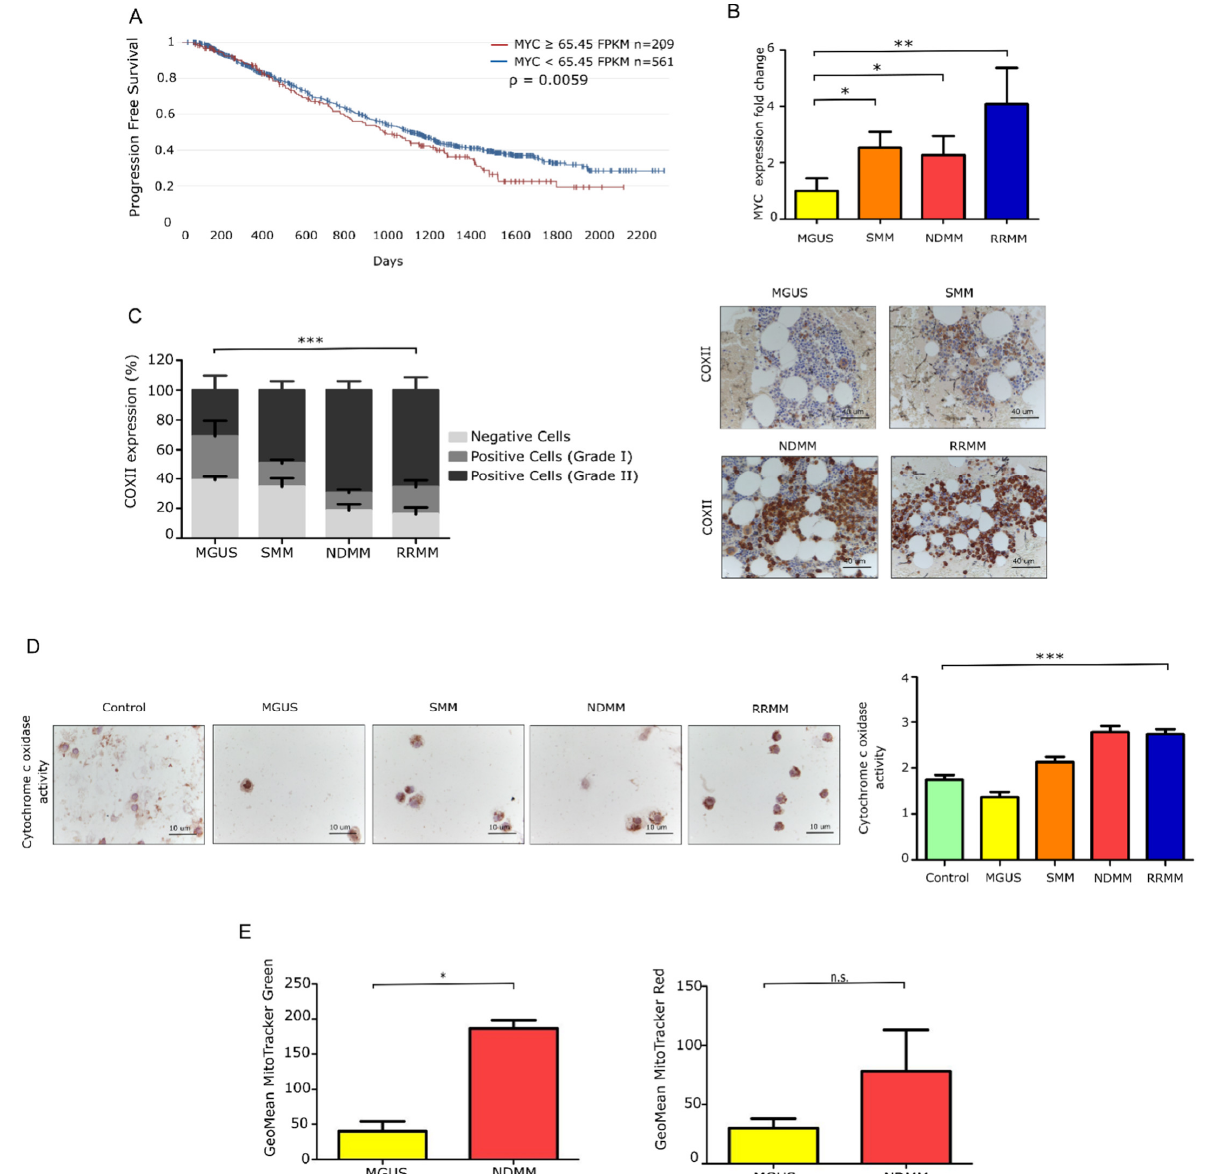
Figure 1. Mitochondrial features in primary MM cells from distinct myeloma entities. ( A ) Progression-free survival (PFS) of MM patients from the CoMMpass study (IA14) stratified according to MYC gene expression. ( B ) Fold-change in gene expression of MYC relative to GUS B expression (MGUS N = 9; SMM N = 9; NDMM N = 18; RRMM N = 11). Data are presented as mean values ± SEM of technical triplicates. ( C ) Intracellular expression of COXII in samples from MM patients ( N = 4 MGUS, N = 7 SMM, N = 13 NDMM, and N = 11 RRMM). Microscopy analysis of the immunohistochemistry (IHC) slides from bone marrow samples ( p value = 0.0001). Representative images addressing differences in COXII expression between patients at different stages of the disease. Scale bar, 40 µm. Data are presented as mean values ± SEM. Statistical significance was assessed using two-way ANOVA. ( D ) Histoenzymatic reaction to cytochrome c oxidase enzyme (HE-COX) in donors and patients across the different stages of the disease ( N = 2 donor, N = 4 MGUS, N = 5 SMM, N = 5 NDMM and N = 4 RRMM). Relative HE-COX scores in fresh plasma cells (CD138+) ranging from Grade 0: no stain; Grade 1: low stain; Grade 2: medium stain; Grade 3: high stain; Grade 4: very high stain. Representative images show different intensity stains related to enzyme activity. Data are presented as mean values ± SEM. ( E ) Mitochondrial mass and membrane potential in MM patients ( N = 3 MGUS, N = 3 NDMM), assessed by flow cytometry. Data represent the geometric mean ± SEM of three independent experiments. * p < 0.05, ** p < 0.001, *** p < 0.0001, n.s. no significance.